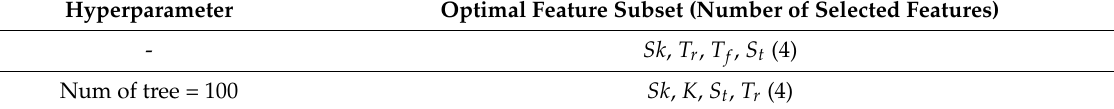
Figure 7. RFECV results of ( a ) Model 1 and ( b ) Model 2 for the spill location for finding the optimum number of features for each ML model. Table 6. Hyperparameter and optimal feature subset from RFECV of the spill location predictor.